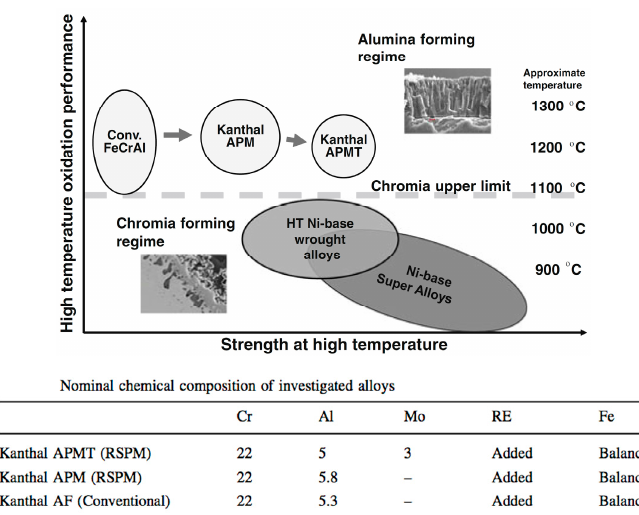
Figure 6. Fe-Cr-Al oxide dispersion strengthening (ODS) (KANTHAL©) currently produced or previously investigated at SANDVIK for very high temperature, 900–1350 °C (credit SANDVIK). The comparison from sagging test between a KANTHAL© ODS and a Fe35Ni25Cr superalloy after 2300 h at 1100 °C in carburizing atmosphere shows greater damage (oxidation and creep) rate in the superalloy. RSPM stands for rapid solidification powder, RE stands for rare earths and HT stands for high temperature (reprinted from [76], with permission of Bo Jönsson and with permission of Springer).